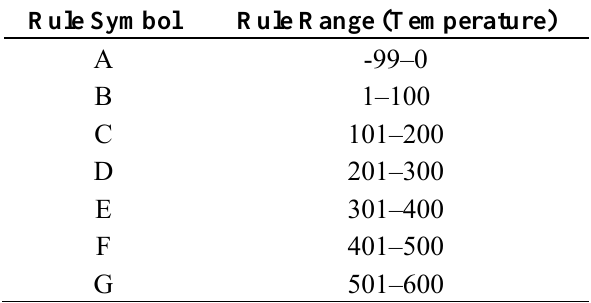
Table 6. Rules description for